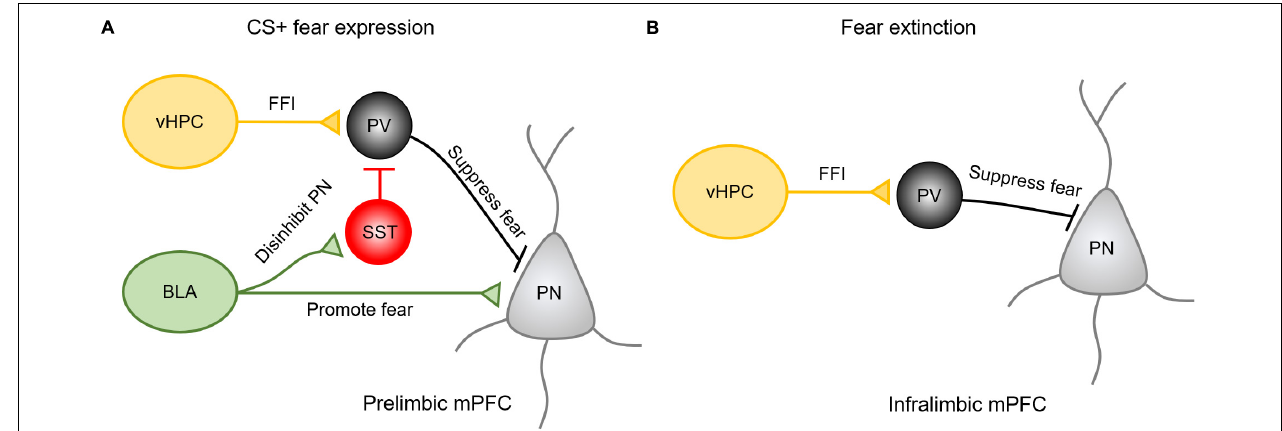
FIGURE 2 | The vHPC and amygdala inputs in the mPFC exhibit regional specificity and differential mechanisms in regulating fear expression and extinction. (A) Upon presenting conditioned cues, BLA inputs could activate projecting pyramidal neurons in the PL to drive fear expression or activate SST-INs to disinhibit pyramidal neurons in promoting the fear expression. Meanwhile, vHPC inputs drive feedforward inhibition (FFI) by recruiting PV-INs to prevent these projecting neurons from the fear response. (B) During extinction, vHPC inputs drive feedforward inhibition onto the amygdala projecting neurons in the IL to suppress the relapse of